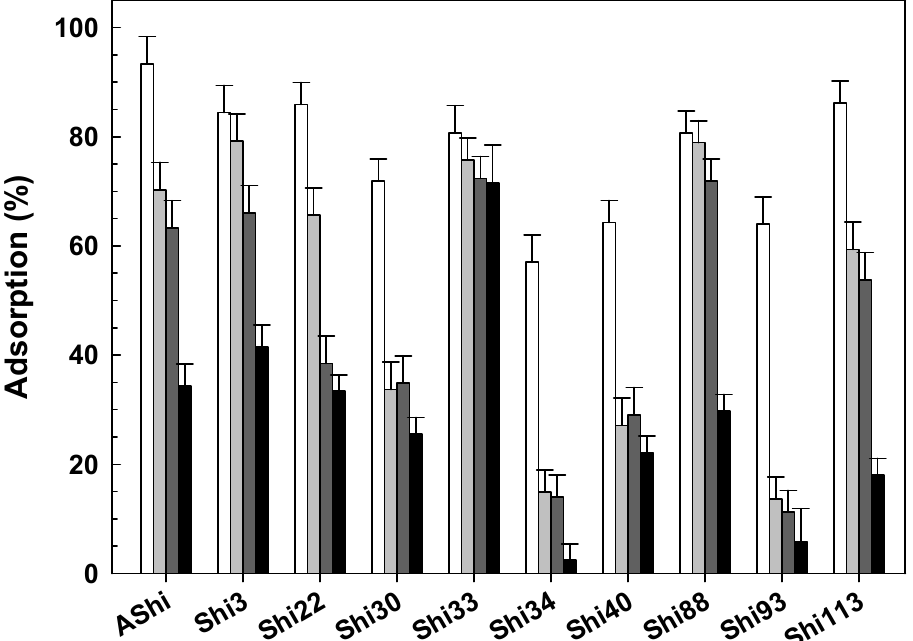
◦ Figure 2. Phage adsorption in TSB at 4 °C (  ), 25 °C (  ; control), 37 °C (  ) and 50 °C (  ) on Figure 2. Phage adsorption in TSB at 4 °C (  ), 25 °C (  ; control), 37 °C (  ) and 50 °C (  ) on Figure 5. Phage adsorption in TSB at 25 C without ( Figure 2. Phage adsorption in TSB at 4 °C (  ), 25 °C (  ; control), 37 °C (  ) and 50 °C (  ) on ATCC12022 viable cells. Values are the mean ± standard deviation (error bars) of three ATCC12022 viable cells. Values are the mean ± standard deviation (error bars) of three ATCC12022 viable cells. Values are the mean ± standard deviation (error bars) of three determina- Figure 2. Phage adsorption in TSB at 4 °C (  ), 25 °C (  ; control), 37 °C (  ) and 50 °C (  ) on Figure 5. Phage adsorption in TSB at 25 °C without (  ) and with 5 g dL − 1 (  ), 10 g dL − 1 (  ) and 20 ) of sucrose on ATCC12022 viable cells. Values are the mean ± standard deviation (error determinations. determinations. tions. g dL − 1 (  ) of sucrose on ATCC12022 viable cells. Values are the mean ± standard deviation (error ATCC12022 viable cells. Values are the mean ± standard deviation (error bars) of three bars) of three determinations. bars) of three determinations. determinations.